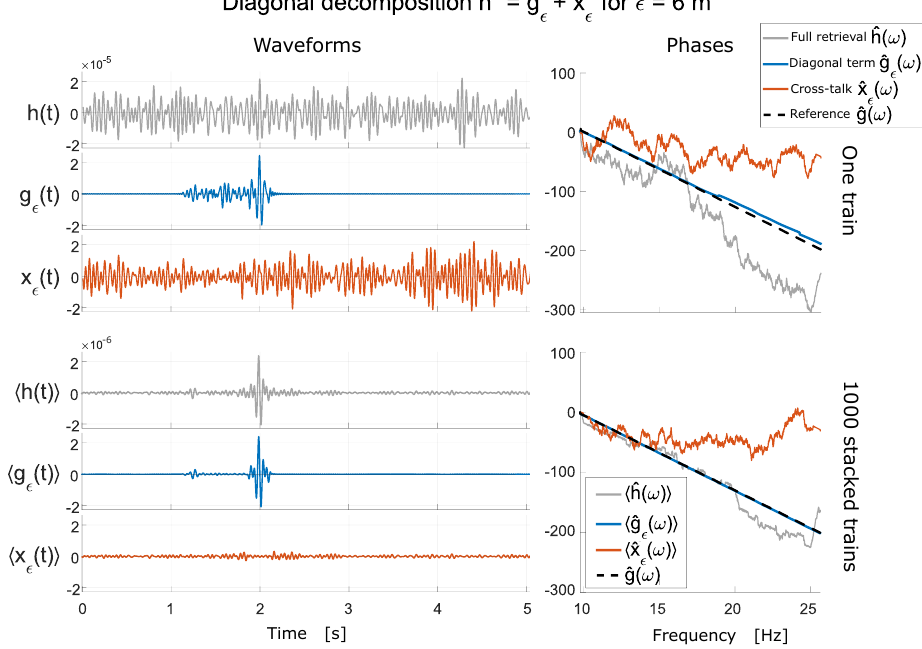
Figure 5. Example of the (cid:101) -diagonal decomposition procedure Equation (16) and its stacking average version Equation (17) for a train travelling at 90km/h with the emitted spectrum between 10Hz and 25Hz. The receiver pair was placed perpendicularly to the road, with an inter-receiver distance of 2000 m and a distance of 400 m from the source-line to the closest receiver. The medium speed was set at 1000 m/s. The decomposition is performed for (cid:101) = 6m ( T (cid:101) = 0.25s) determined from Equation (15) for a single five-minute recorded source train ( top ) and for a stacked retrieval over 1000 five-minute train source recordings ( bottom ). The left panels show the waveforms of the components Equations (16) and (17), and the right panels show the corresponding phases in the frequency domain obtained from the frequency representation of the retrieval given by (cid:10) (cid:11) h ( t ) Equations (10) and (13). The retrieval h ( t ) and its stacking average are shown in gray, and (cid:10) (cid:11) (cid:10) (cid:11) g (cid:101) ( t ) x (cid:101) ( t ) their components g (cid:101) ( t ) , , and x (cid:101) ( t ) , , are shown in blue and orange, respectively. The phase plots include the phase of the inter-receiver Green’s function (dashed black) estimated from discrete sources, as prescribed by Equation (1) as a